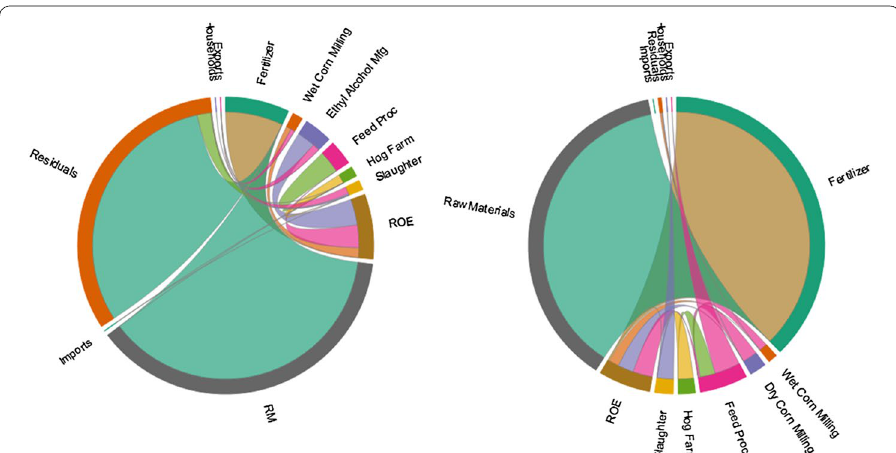
Fig. 5 a Chord diagram depicting flows from the RIC (Table 4) version of the PIOT created with our method. The large green areas represent the interactions between the fertilizer manufacturing sector and raw materials and residuals. b Chord diagram depicting flows from the PIOT prepared by Singh et al. (Additional file 1: A12) The large green area represents the flows from raw materials to fertilizer, and the large brown area represents the flows from fertilizer to the rest of the economy. Note : the perimeter space is proportional to the magnitude of outflow from the sector named. The flow between a sector with each additional sector is shown in a distinct